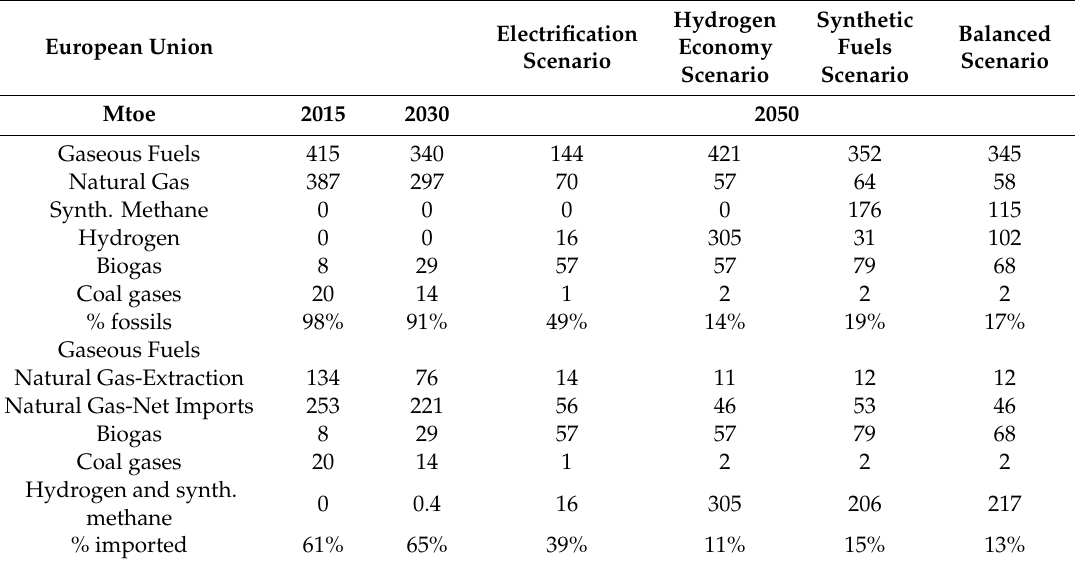
Table 9. Gas utilization